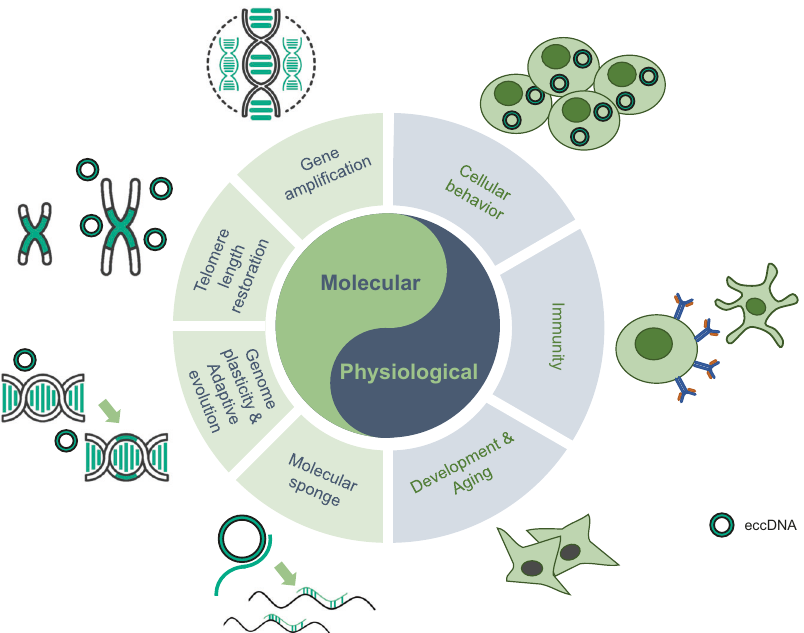
Fig. 5 The molecular and physiological functions of eccDNAs. EccDNA regulates diversi fi ed molecular and physiological processes. Mechanistically, eccDNA plays an important role in gene ampli fi cation, telomere length restoration, genome plasticity, and molecular sponge. EccDNA also plays an important role in multiple physiological events, including cellular behavior, immunity, and